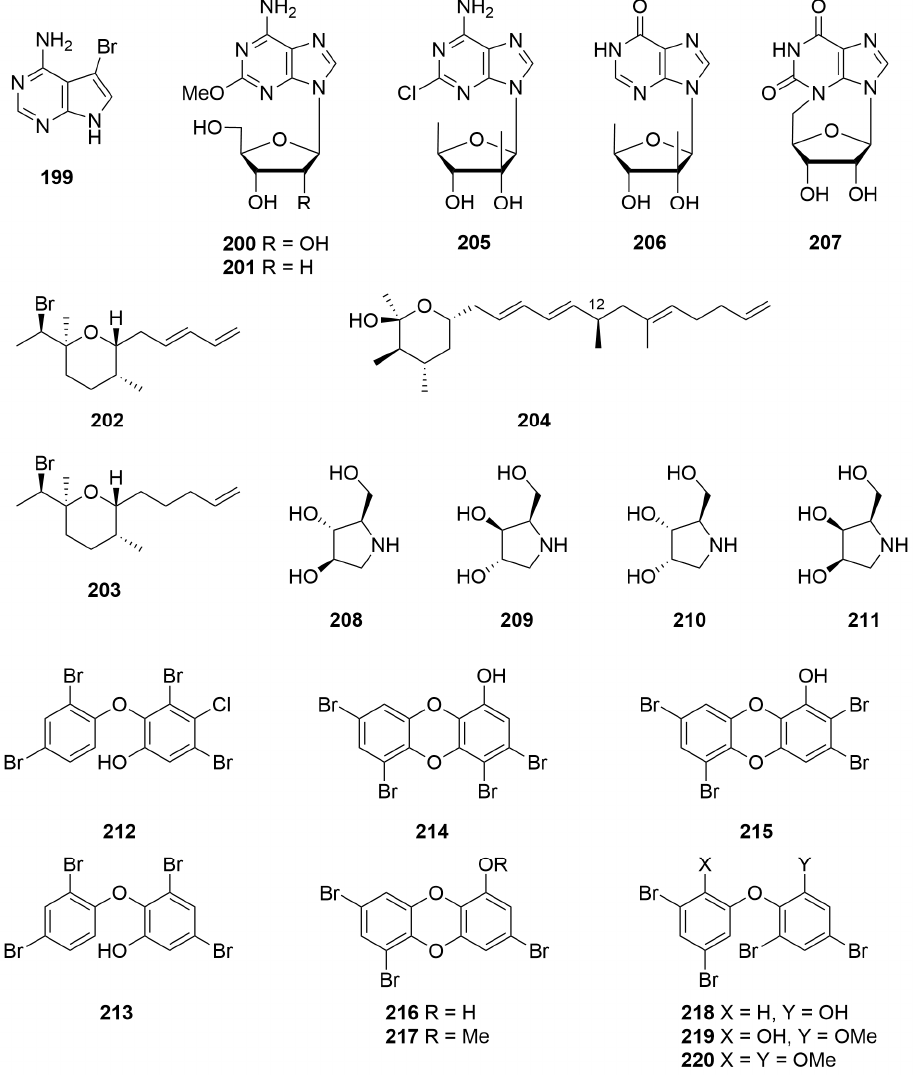
Figure 14. Compounds 197 to 220